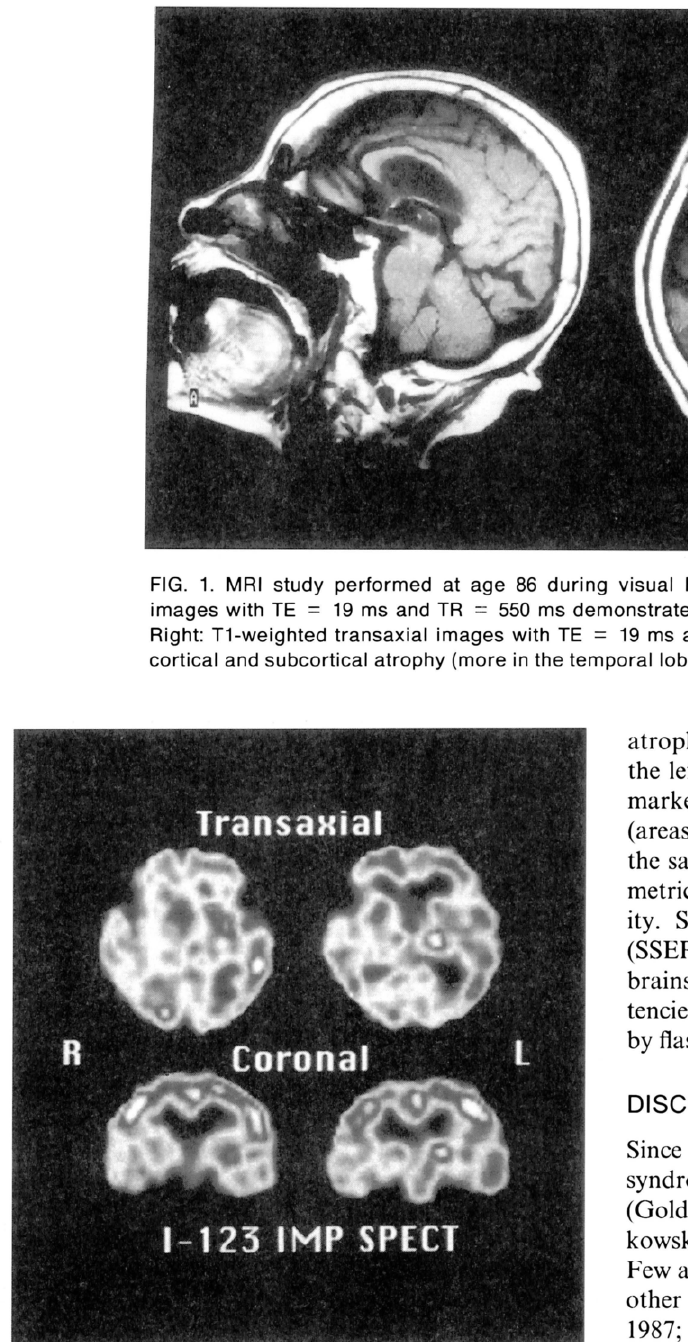
FIG. 2. SPECT study using IMP at the age of 86 years during visual hallucination. Transaxial section disclosed hyperper fusion in the left temporal lobe (both mesial and lateral structures), thalamus, and corpus striatum. Appearances in the occipital lobe were unremarkable. Coronal section disclosed hypoperfusion in the right mesial temporal